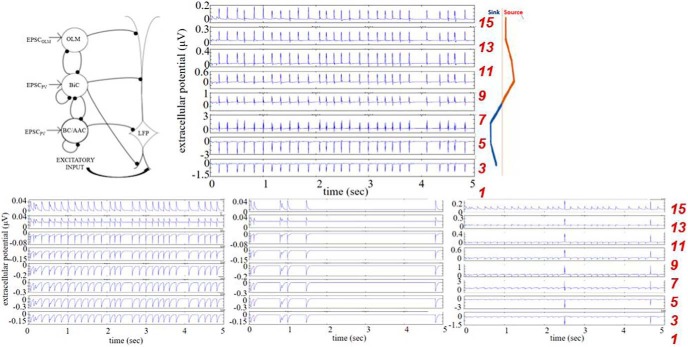
Example LFPs from selected and rejected parameter sets. Computed LFPs are shown across multiple layers. Top, Selected parameter set: gsb = 6, gbs = 1.25 nS. Bottom, Rejected parameter sets (left to right): gsb = 0.5, gbs = 0.75 nS; gsb = 0.5, gbs = 3.5 nS; gsb = 2.5, gbs = 1 nS; csb = 0.21 for all.